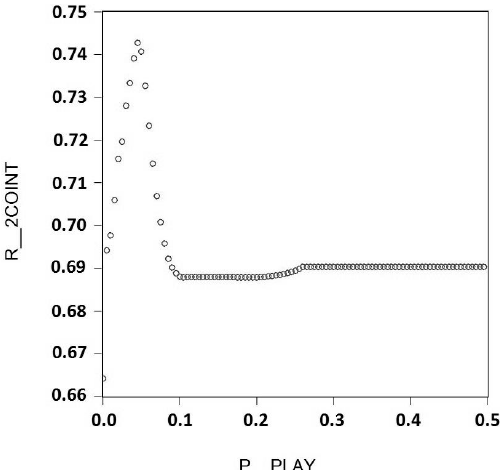
Figure 1. Grid search for Belgian exports to the United Kingdom (Standard International Trade Classification (SITC) 7, constant play area max.: 0.045).